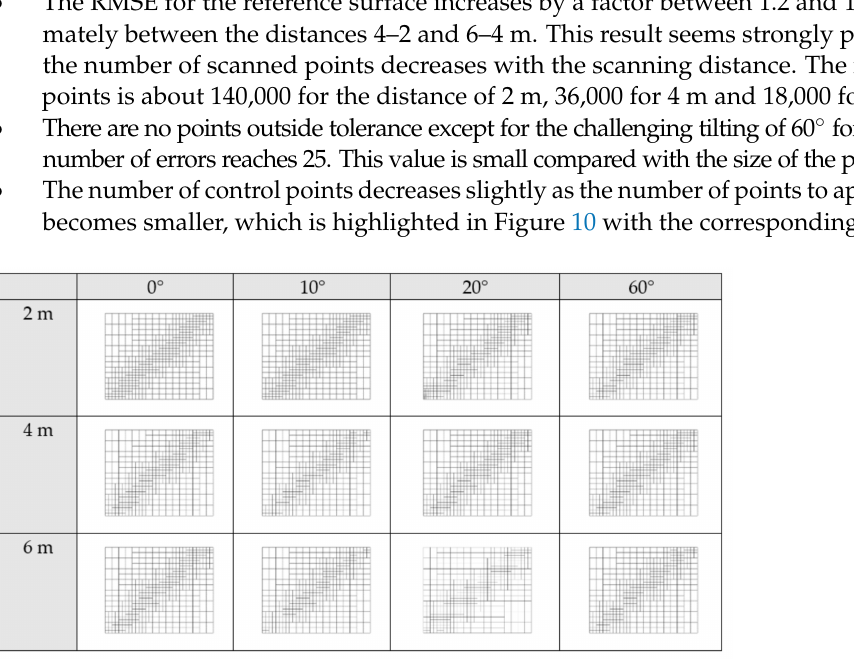
Figure 10. T-meshes corresponding to the different scanning configurations, as presented in Table 2. Both the scanning distance angles were